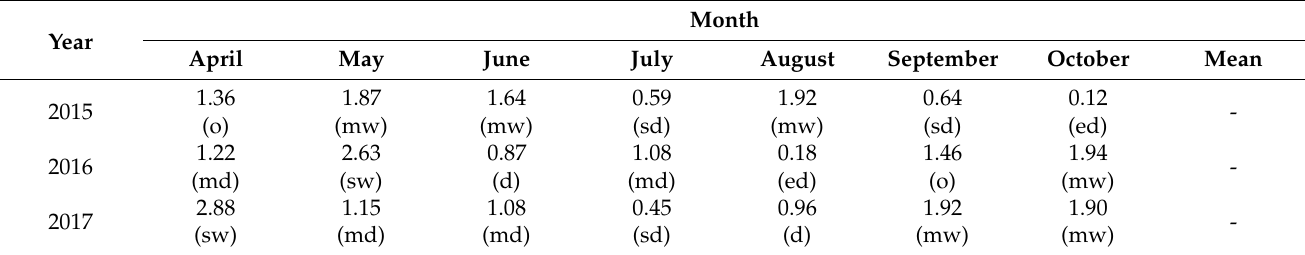
Table 3. The values of Sielianinov’s hydrothermal coefficient (K) in the growing season.